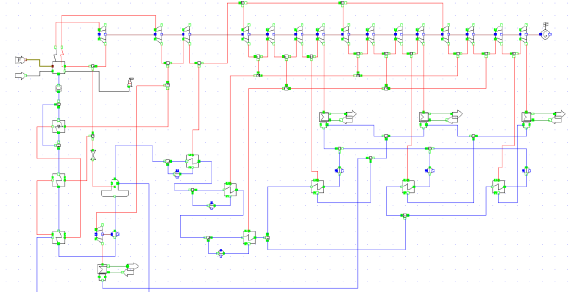
Fig. 1. Reference power unit cycle at Bełchatów Power Plant, 858 MWe. Table 1. Technical data of Bełchatów Power Plant.